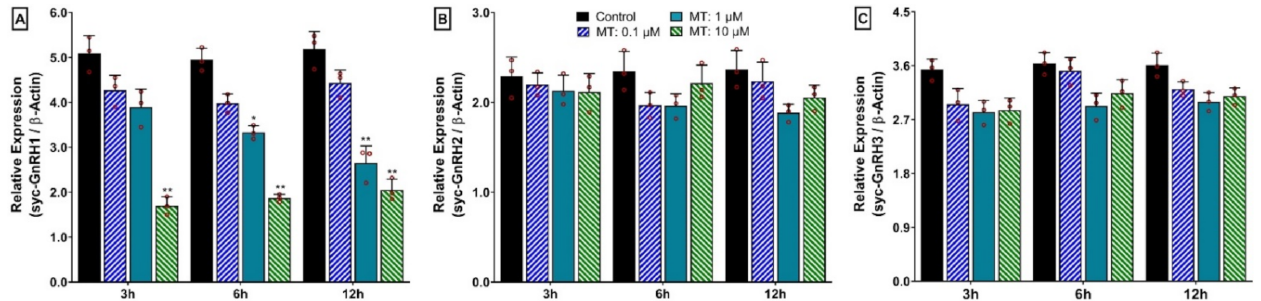
Figure 13. Time- and dose-dependent in vitro effects of 17- α methyltestosterone (MT) on mRNA expression levels of three GnRH isoforms in cultured hypothalamus of small yellow croaker: ( A ) syc- GnRH1, ( B ) syc-GnRH2, and ( C ) syc-GnRH3. MT was applied in the culture media at concentrations of 0.1, 1, and 10 µ M. For all bar graphs, raw data points (red circle) represent biological replicates, error bars represent standard deviation, and asterisks indicate significant differences ( p < 0.05) compared to the zero time point initial